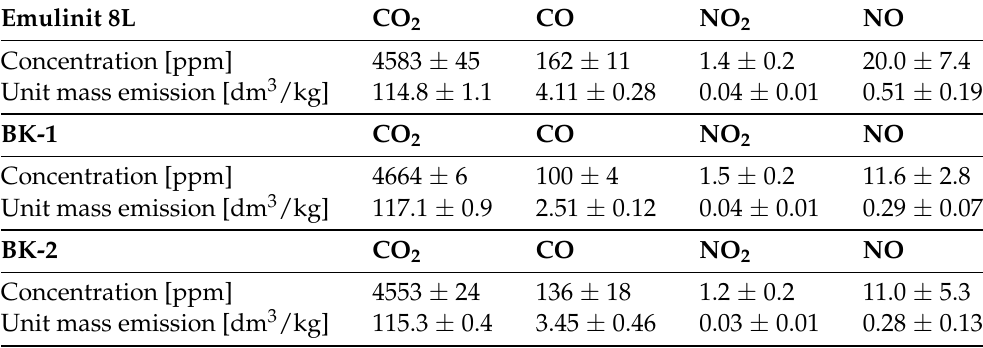
Table 6. Summary of the average composition of post-detonation gases for the tested